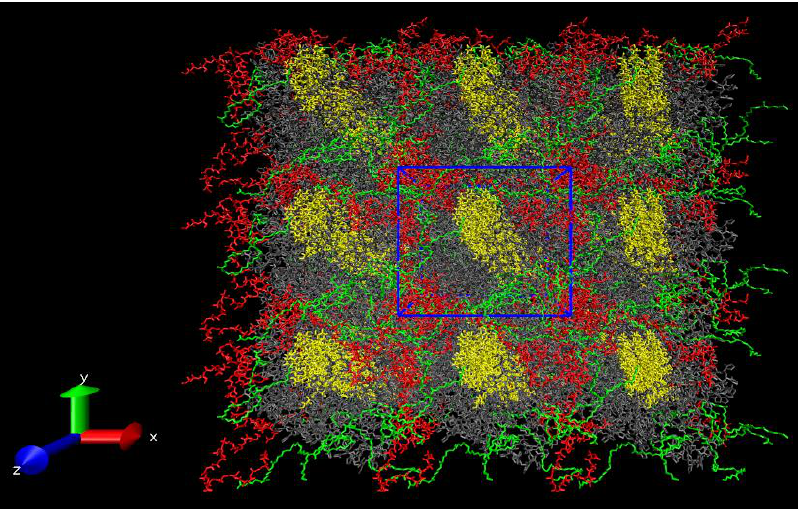
Figure 25. Snapshot of the final configuration of the PHVB/PCL/PVP/CNC composite with periodic images: PVP is colored in grey; CNC is colored in yellow; PHBV is colored in red; PCL is colored in green.